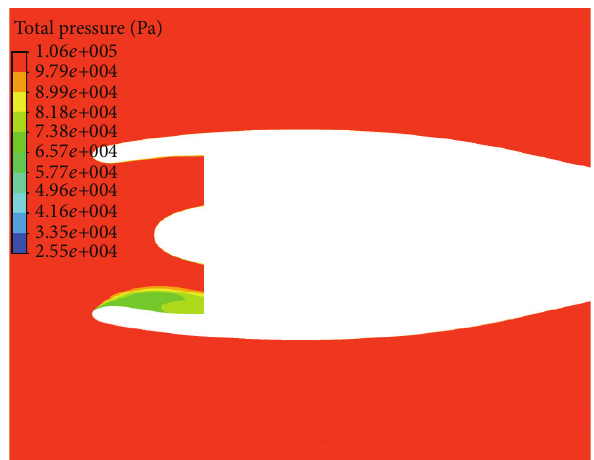
Figure 18: Contours of the total pressure obtained by a transient calculation time step: 600th.